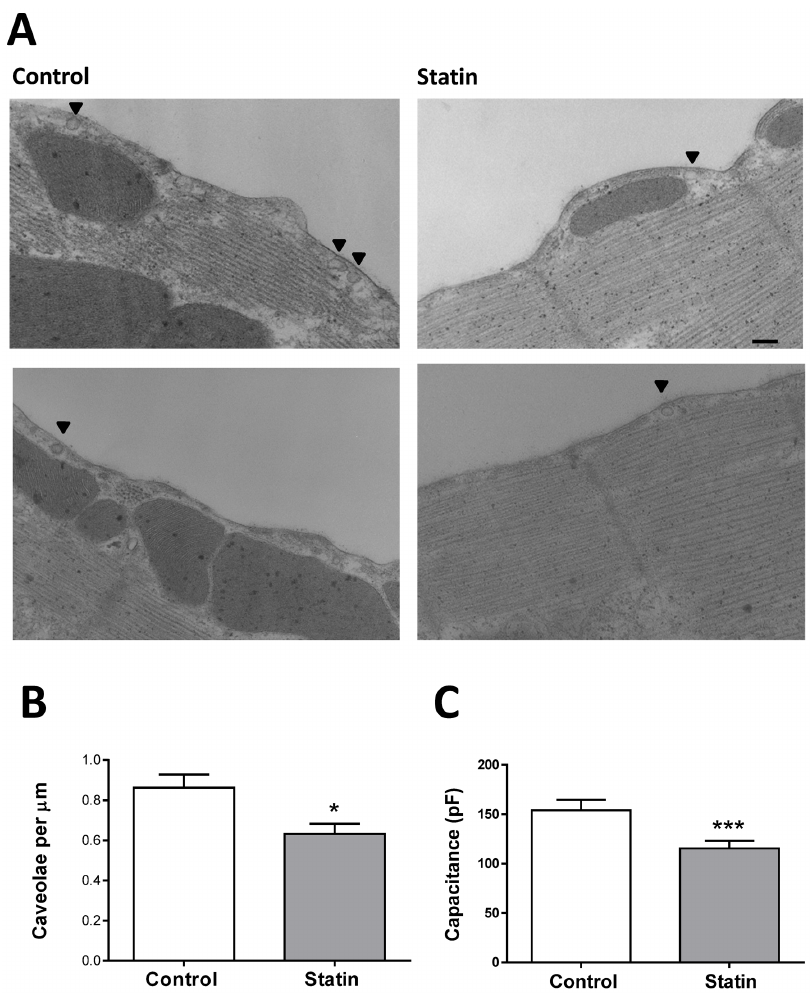
Figure 3. Simvastatin treatment reduces caveolar density. A. Representative membrane from control and simvastatin-treated cardiac myocytes. Arrows indicate caveolae. Scale bar represents 200 nm. B. Simvastatin treatment reduced the mean density of caveolae measured in < 330 m m of membrane (n=9 myocytes from 3 hearts). * P , 0.05, Student’s t-test. C. Simvastatin treatment reduced cell capacitance (n=27–33 cells from 19 hearts). *** P , 0.001 Mann Whitney Rank test.